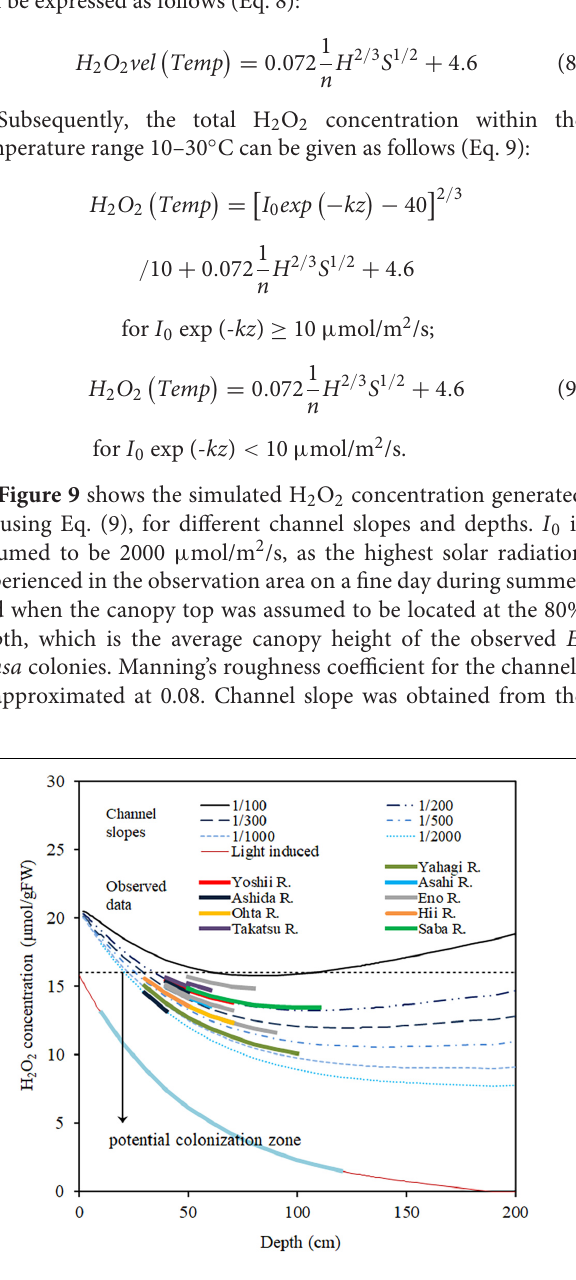
FIGURE 9 | Simulated H 2 O 2 concentration in the plant body of E . densa changes with the water column depth for different channel slopes and actual slope data of several Japanese rivers. The line “Light-induce” represents the H 2 O 2 concentration induced by light and change with the depth. The downward arrow “potential colonization zone” represents the depth zone of different channel slopes suitable for E . densa